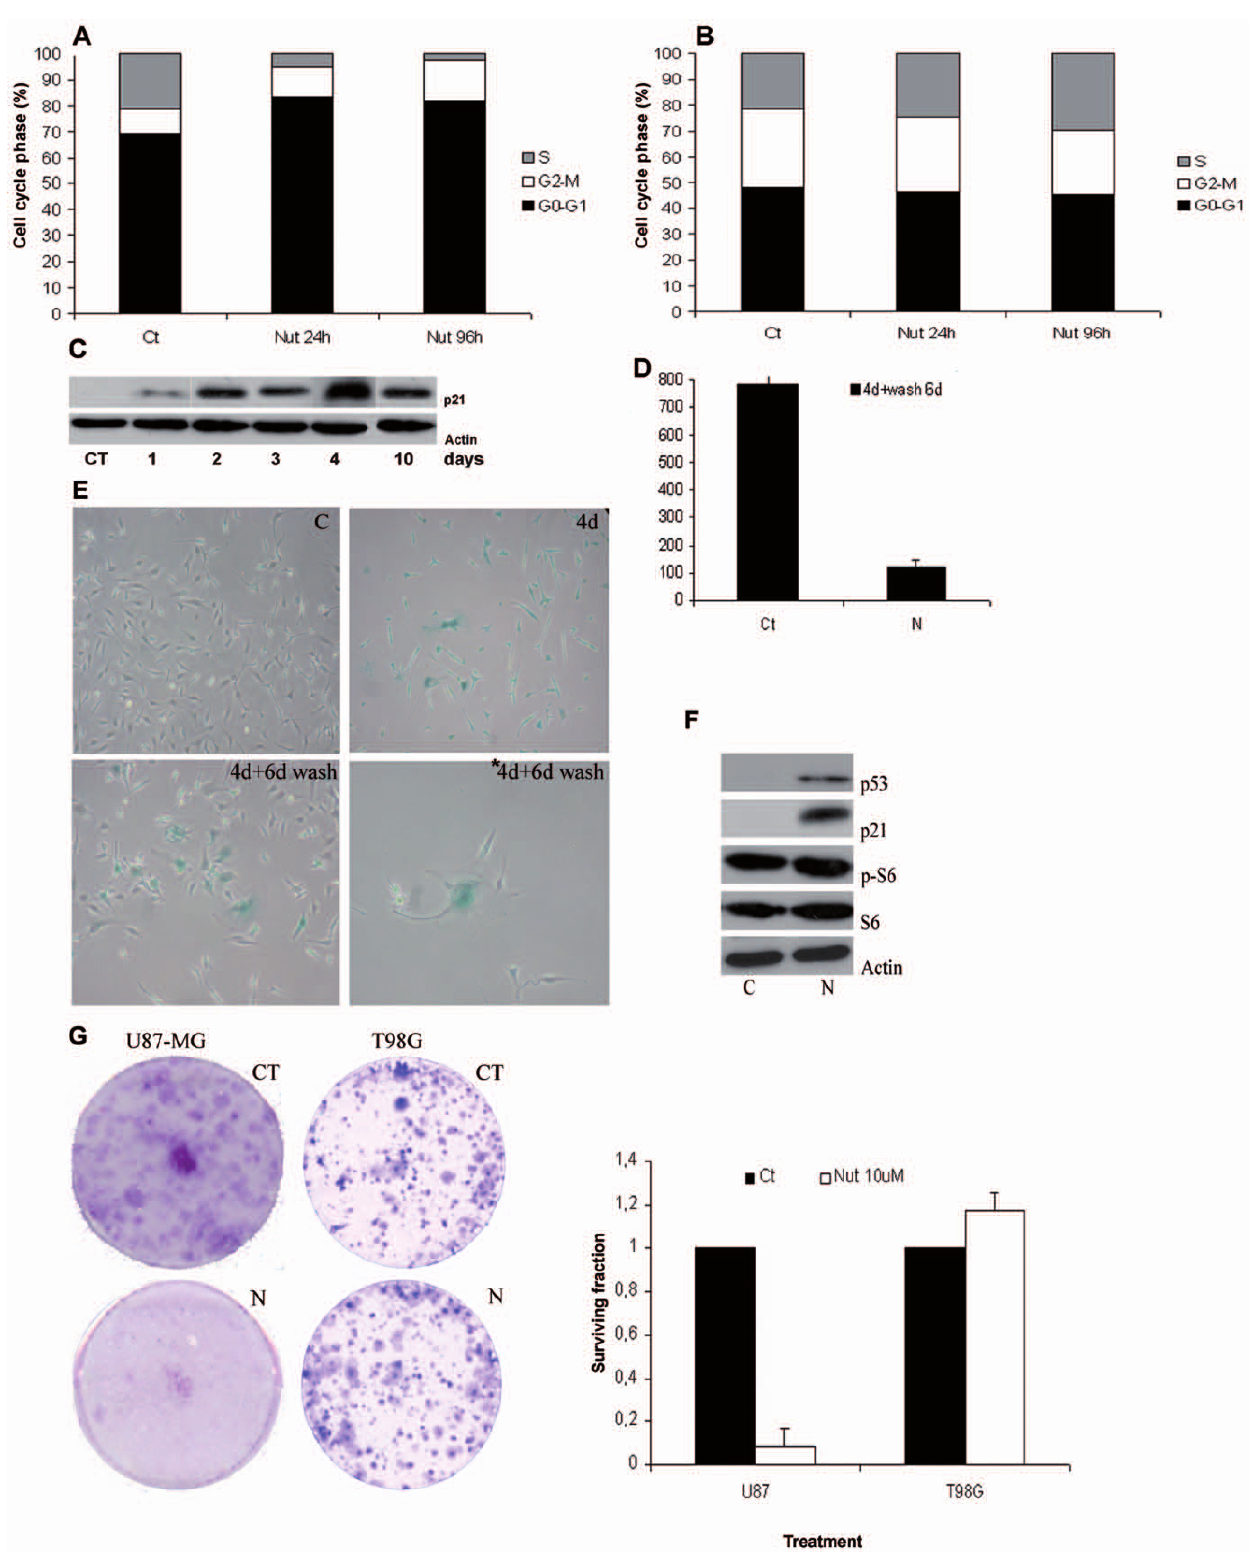
Figure 2. Nutlin-3a induced cell cycle arrest and cellular senescence in U87MG cells. A and B , glioma cell lines (A: U87MG; B: T98G) were treated either with nutlin-3a or DMSO (vehicle control) for 24 to 96 hours, and cell cycle profile was measured by flow cytometry. Columns, average of three independent determinations; C , time-course of p21 protein expression in U87MG cells after nutlin-3a incubation for 1 to 4 days; 10 days showed p21 protein expression on day six after removal of nutlin-3a (day 10 after cells were plated). Immunoblots are representative of at least three independent experiments; D , U87MG cells were treated with nutlin-3-a for 4 days, then washed to remove the drug and incubated for additional six